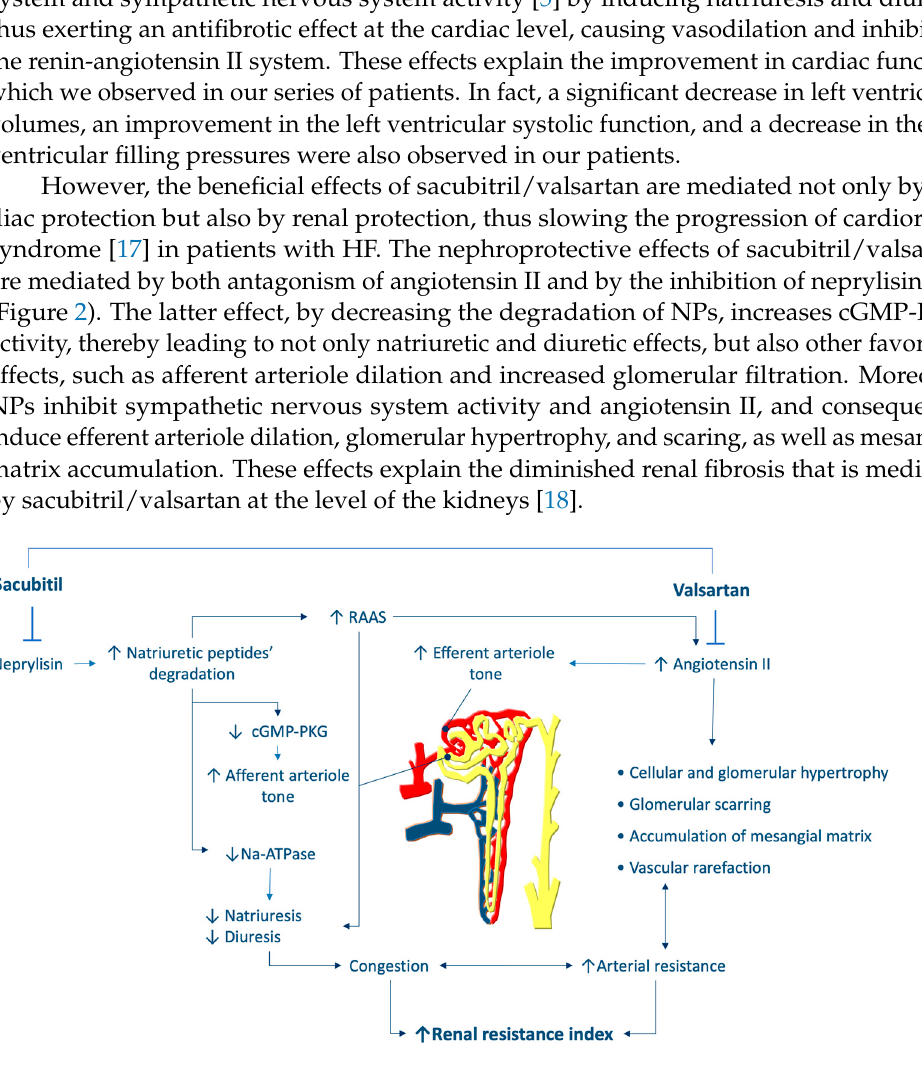
Figure 2. Hypothesis regarding the effects of sacubitril/valsartan on renal resistance. RAAS: renin- angiotensin system.